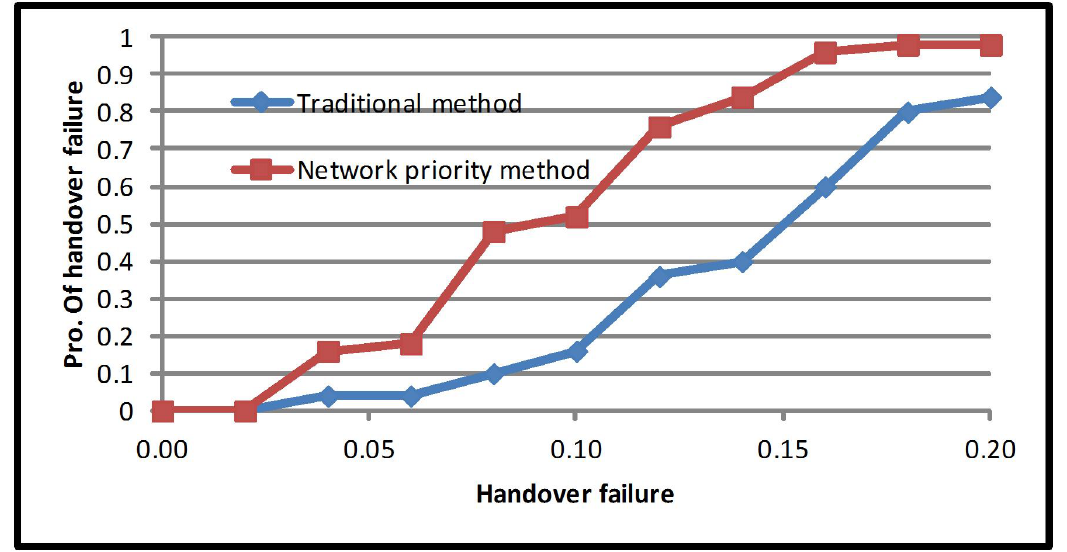
Figure 7. Average handover failure probability of the network priority